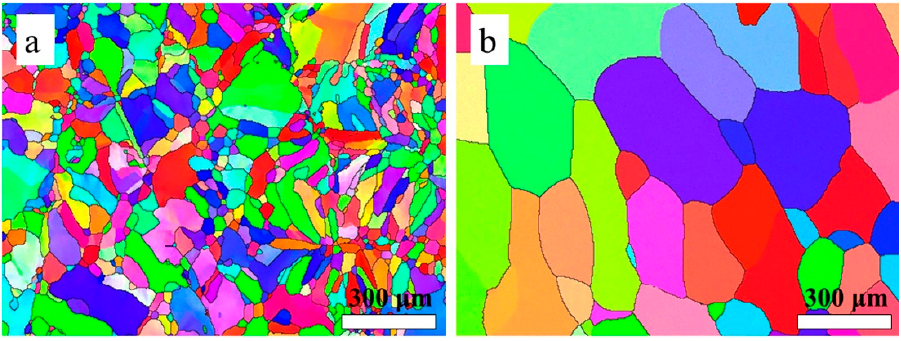
Figure 7. EBSD (Electron Backscattered Diffraction) image of ( a ) as-printed sample; ( b ) as-cast sample.